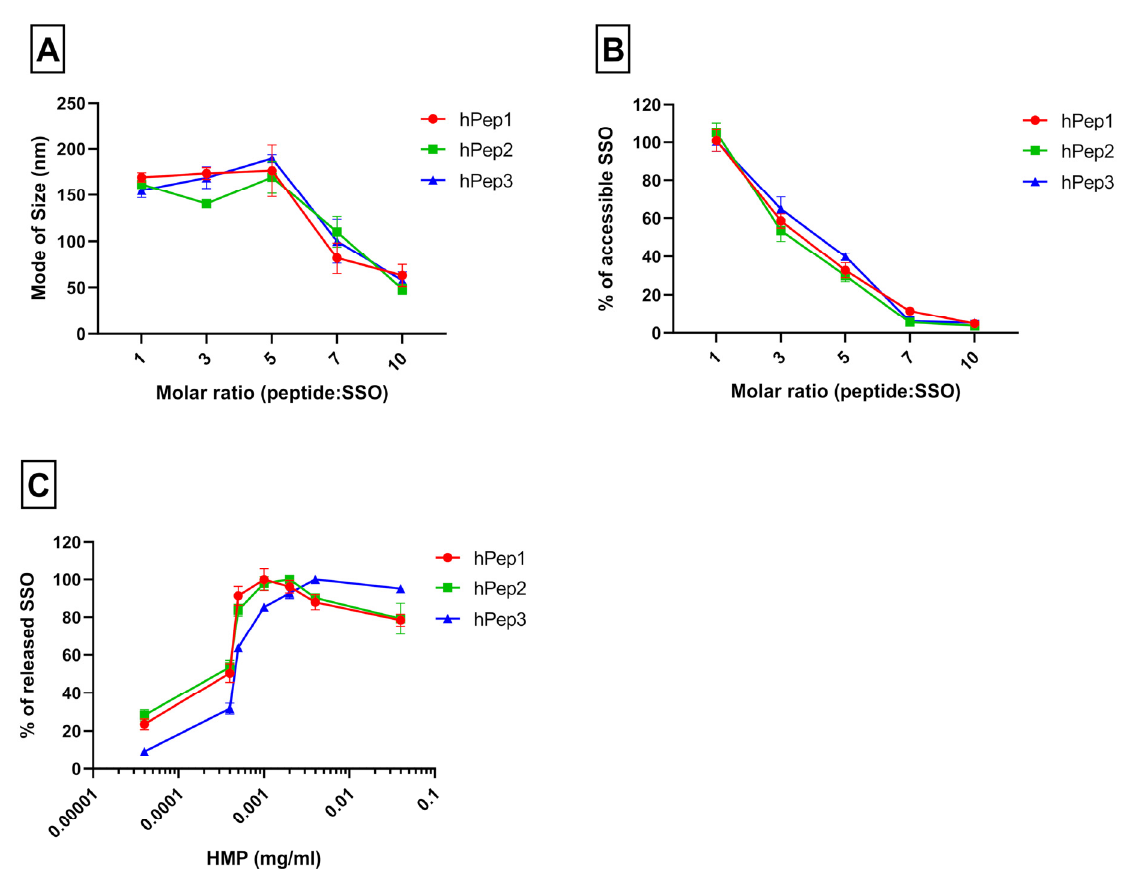
Figure 1. Physicochemical characterization and stability of hPep/SSO nanoparticles. ( A ) Size of the peptide/SSO nanopar- ticles formulated over a range of peptide-to-SSO molar ratios evaluated by Nanoparticle Tracking Analysis (NTA). ( B ) The encapsulation efficiency of the peptide/SSO nanoparticles was measured by SYBR Gold exclusion assay. ( C ) The same assay was used to evaluate the stability of the complexes, challenged by the presence of a competitive polyanion, hex- ametaphosphate (HMP), to release the SSO. Values indicate the mean of three independent experiments measured in triplicates (mean ± SEM).